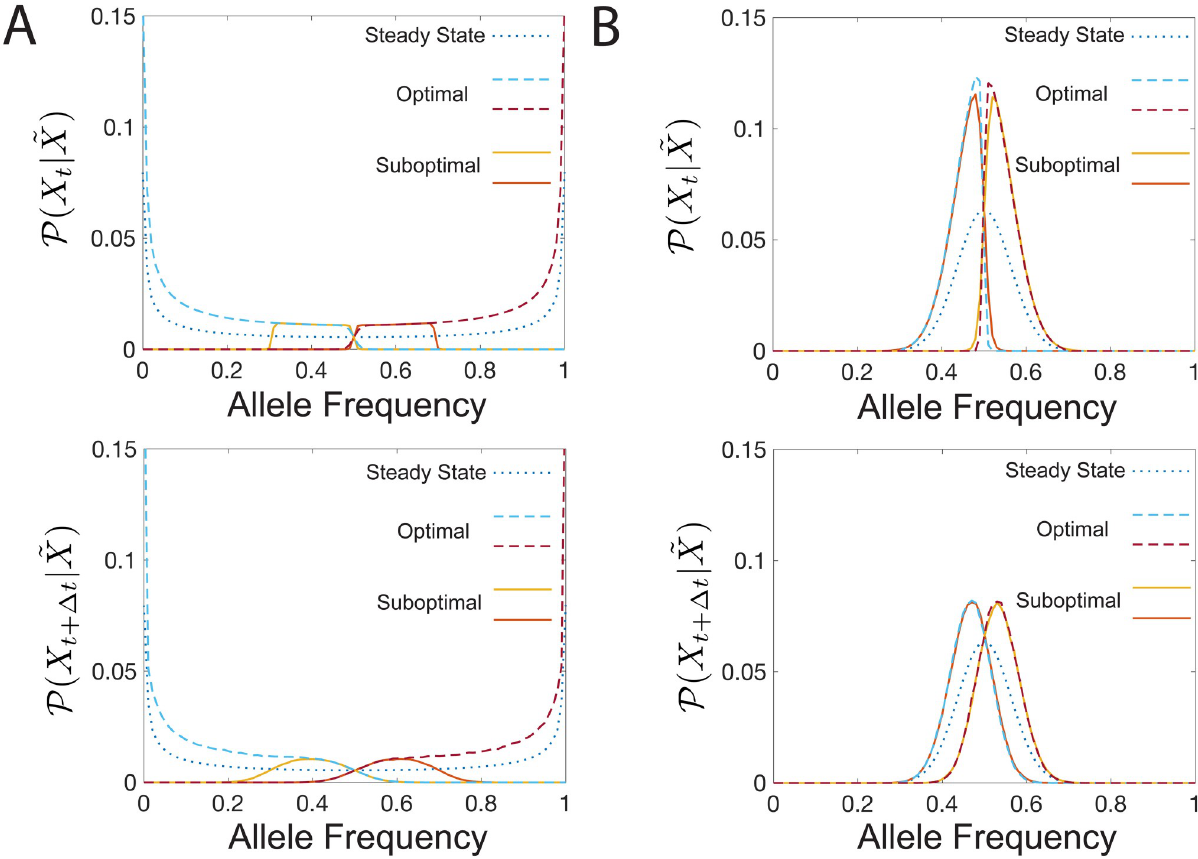
Fig 9. Transferability of prediction schemes in Wright-Fisher dynamics. We transfer a mapping, P ð ~ X j X Þ , trained on one set of parameters and t apply it to another. We consider transfers between two choices of mutability, Nμ 1 = 0.2 (low) and Nμ 2 = 20 (high), with N = 100, Ns = 0.001, Δ t = 1. The dotted line is the steady state allele frequency distribution, the solid lines are the transferred representations, and the dashed lines are the optimal solutions. The top panels correspond to the distributions of X and the bottom panels correspond to distributions of X . (a) Transfer from high to low t t + Δ t mutability. Optimal information values: I past ¼ 0 : 98 and I future ¼ 0 : 93 ; transferred information values: I past ðð N m Þ ; I ¼ 0 : 92 ! ð N m ÞÞ ¼ 0 : 14 2 1 optimal transfer past optimal and I future ðð N m Þ ; I ¼ 0 : 92 ! ð N m ÞÞ ¼ 0 : 05 . Representations learned on high mutation rates are not predictive in the low mutation regime. (b) 2 1 past transfer ¼ 0 : 92 and I future ¼ 0 : 92 and I future ¼ 0 : 28 . Transferred information values: Transfer from low to high mutability. Optimal information values: I past optimal optimal optimal ðð N m Þ ; I ¼ 0 : 98 ! ð N m ÞÞ ¼ 0 : 79 and I future ðð N m Þ ; I ¼ 0 : 98 ! ð N m ÞÞ ¼ 0 : 27 . Transfer in this direction yields good predictive I past 1 2 1 2 transfer past past transfer